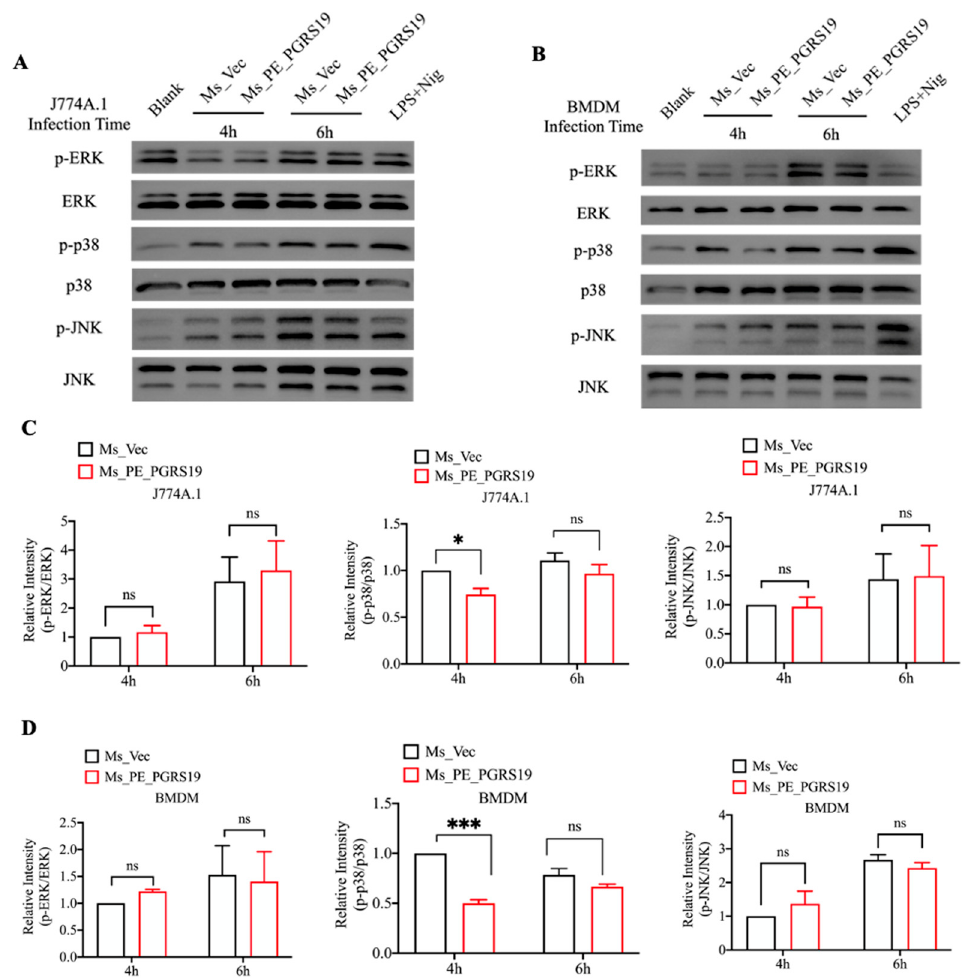
Figure 6. Inhibition of the p38 pathways in Ms_PE_PGRS19-infected macrophages. After infection with Ms_PE_PGRS19 and Ms_Vec at 0, 4 and 6 h, the phosphorylation levels ( A ) and relative intensity ( C ) of MAPK pathway proteins ERK, p38 and JNK were detected in J774A.1. The phosphorylation levels ( B ) and relative intensity ( D ) of MAPK pathway proteins ERK, p38 and JNK were detected in BMDM cells. LPS treatment (4 h) and nigericin stimulation (2 h) were used as positive controls. The relative intensity of blank group was set as a baseline for quantification and analyzed by image J. Data are presented as x ̄ ± SEM of three independent experiments. * p < 0.05, *** p < 0.001.